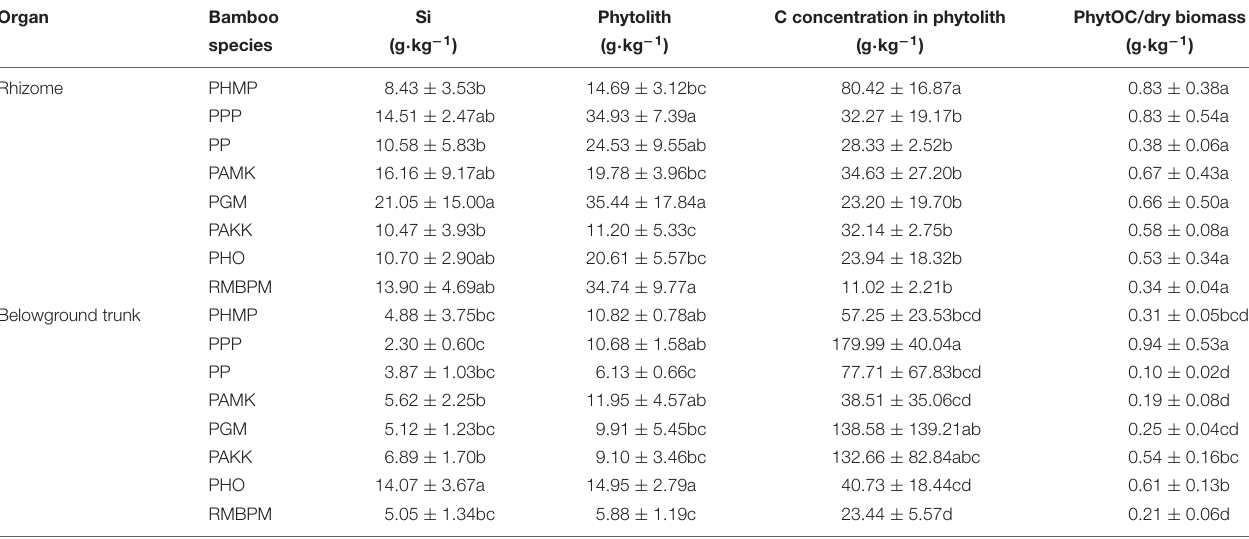
TABLE 3 | The concentrations of Si and phytolith, C concentration in phytolith and PhytOC/dry biomass in the belowground trunk and rhizome of eight monopodial bamboo species. Organ Bamboo Si Phytolith C concentration in phytolith PhytOC/dry biomass species Rhizome